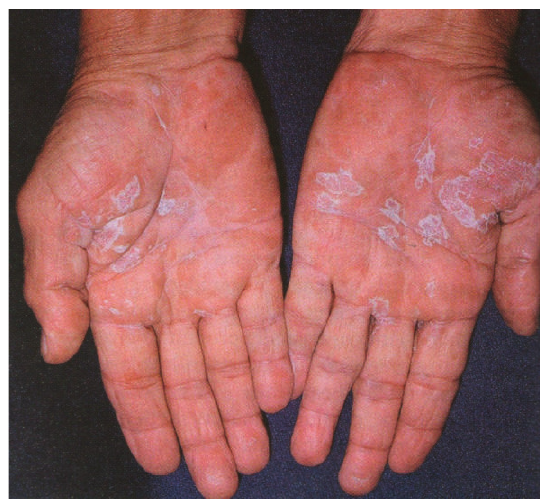
Figure 11: Drug-included skin reaction to gold [4, page